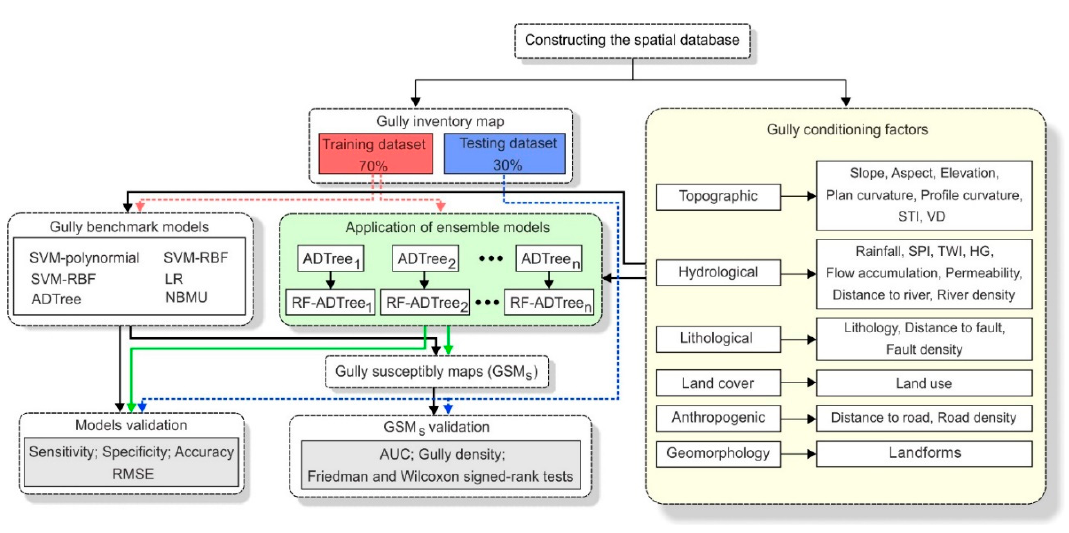
Figure 3. The flowchart of the study.